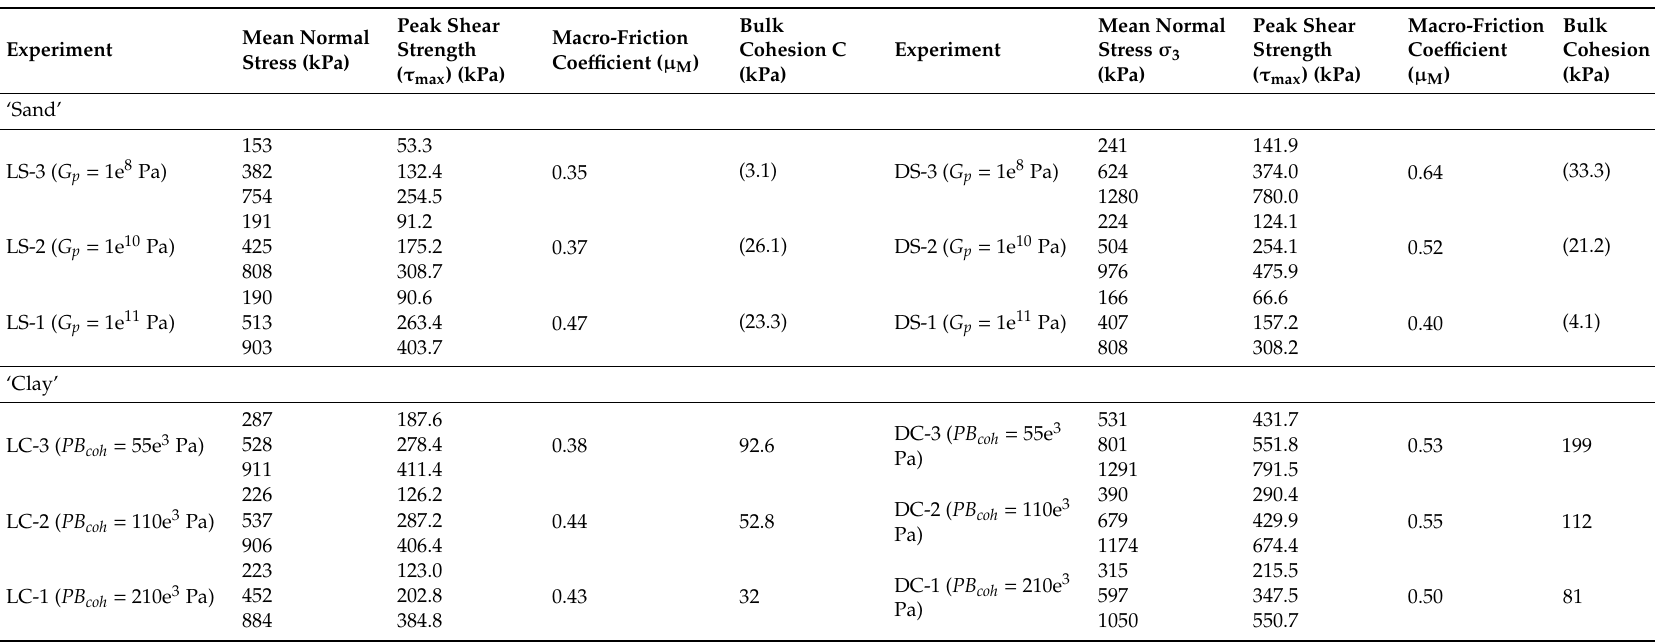
Table 2. Calculated macro-properties of di ff erent material samples: LS: loose ‘sand’, DS: dense ‘sand’, LC-loose ‘clay’, DC-dense ‘clay’. Numbers in brackets are cohesion values, as measured from the linear regression of the failure